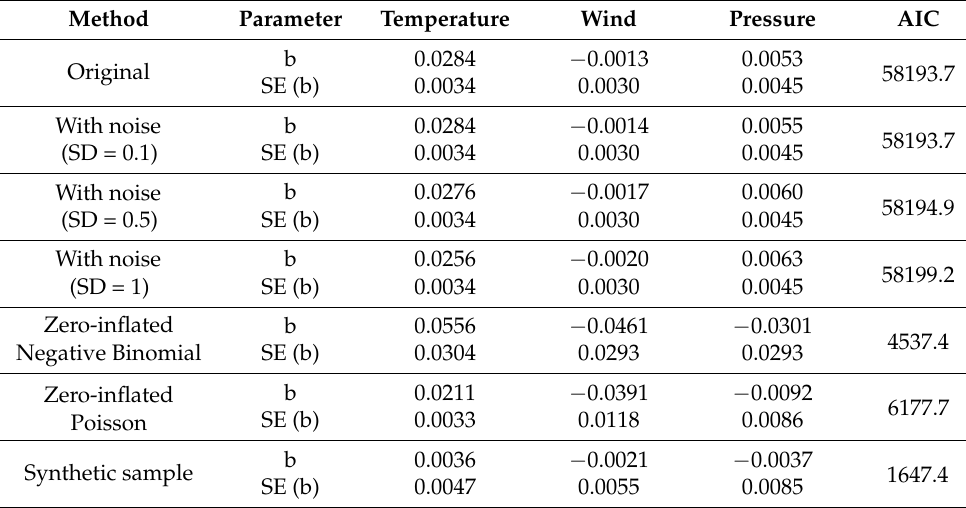
Table 2. Performance evaluation between comparative methods (patent keyword